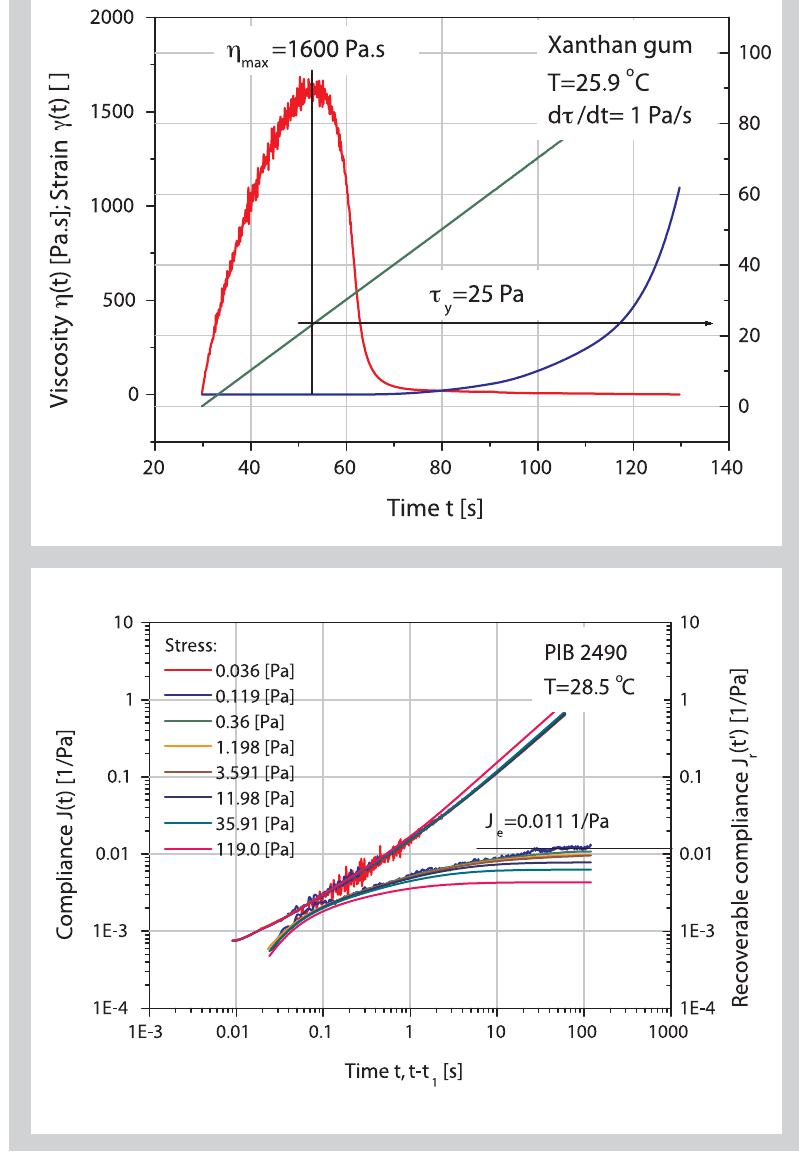
Figure 2 (above): Creep Recovery experiments performed on the NIST PIB2490 standard in the stress range from 0.03 to 120 Pa. Figure 3: Stress Ramp performed on a 4 wt% Xanthan gum solu- tion at a ramp rate of